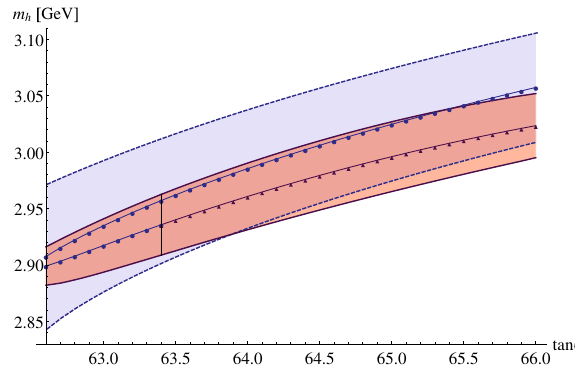
Fig. 1 Mass eigenstates of the heavier CP-even neutral scalar Higgs boson H in the type II Z 2 -symmetric model. Vacuum-stable solutions are shown as blue circles with dashed borders, vacuum-unstable solu- tions as violet triangles, with the black vertical line marking the transi- tion point. The uncertainty estimate is given by the difference between results for calculating the running of all couplings at one-loop and two- loop level, respectively